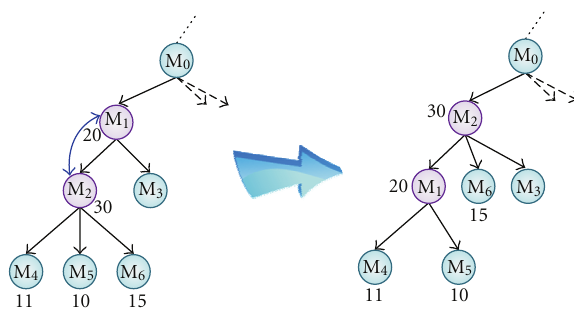
Figure 7: Example of ABTP optimization for a SIPTVMON